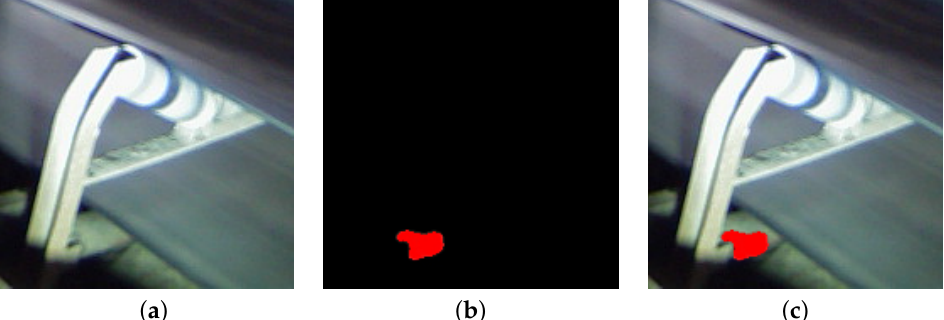
Figure 12. Fusion of thermal and RGB images for validaiton and localization of detected hotspots. ( a ) RGB image, ( b ) The blob detection, ( c ) RGB and blob detecion fusion results.